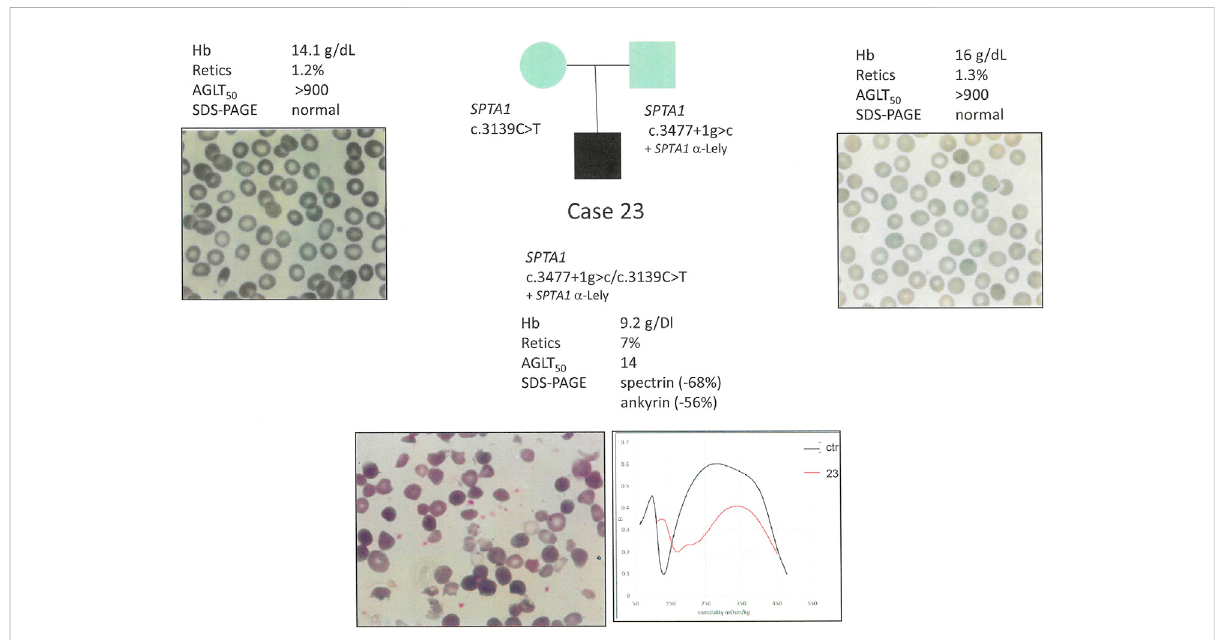
FIGURE 3 Case 23: Family segregation of the variants, RBC peripheral blood fi lms (100× magni fi cation) and hematological data of the proband and